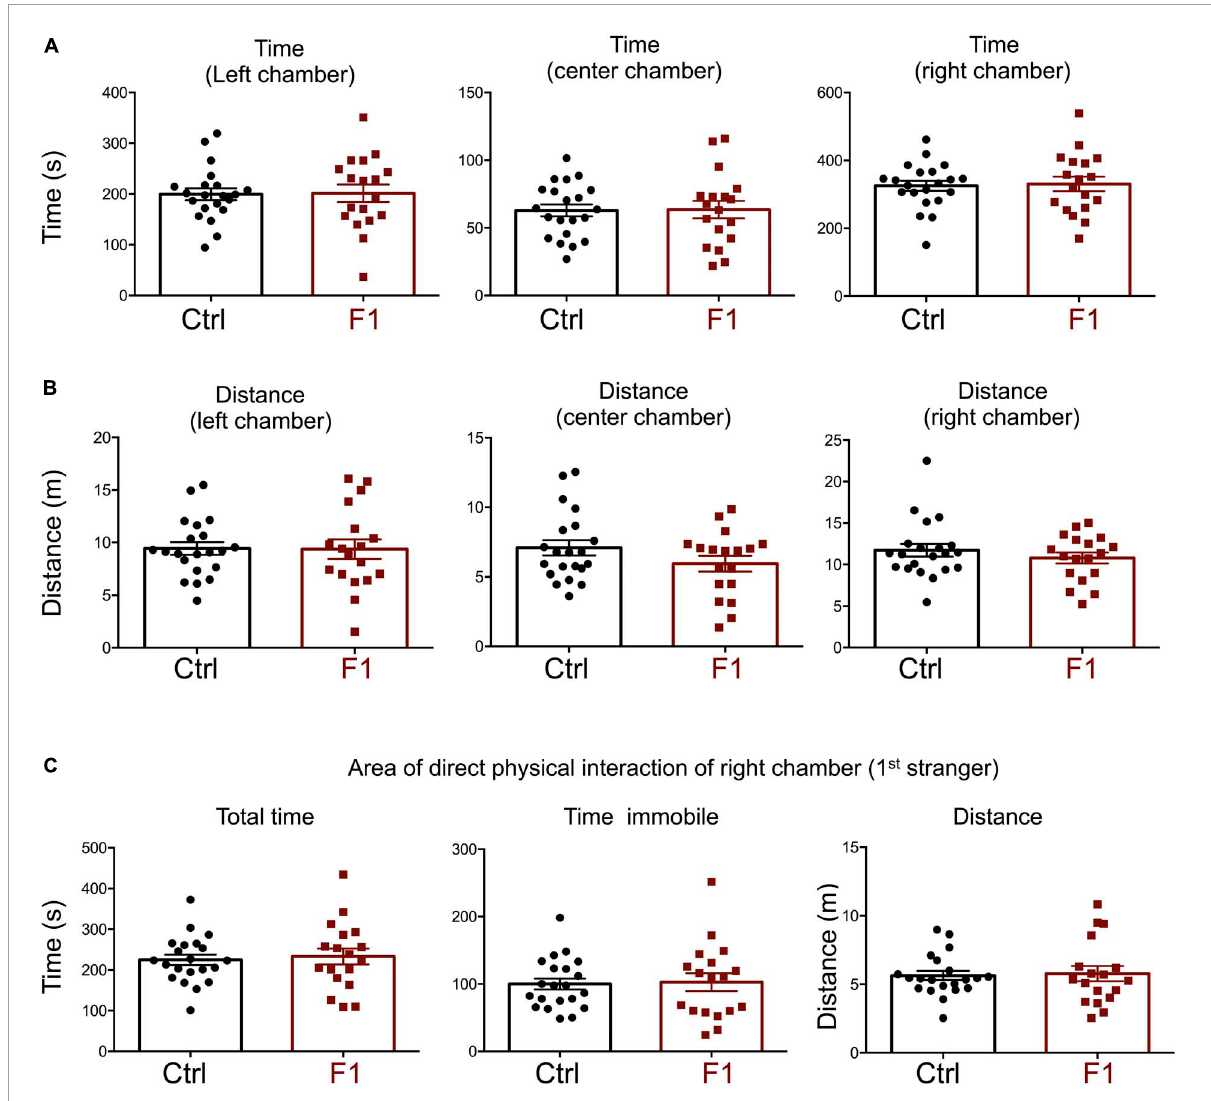
FIGURE5 Sociability of F1 generation males. (A–C) Second trial of the three-chamber social box test, after first stranger is introduced in the right chamber. (A) Time spent by the test mouse in each chamber. (B) Distance traveled by the test mouse in each chamber. (C) Total time, time immobile, and distance traveled by the test mouse in the area immediately around the 1st stranger in the right chamber. Each point represents a different mouse tested at approximately 18 weeks of age ( n = 22, 20) and mean ± SEM are shown. Experimental mice from each group represent 4–6 different litters and data represent two animal cohorts that were generated and tested at different